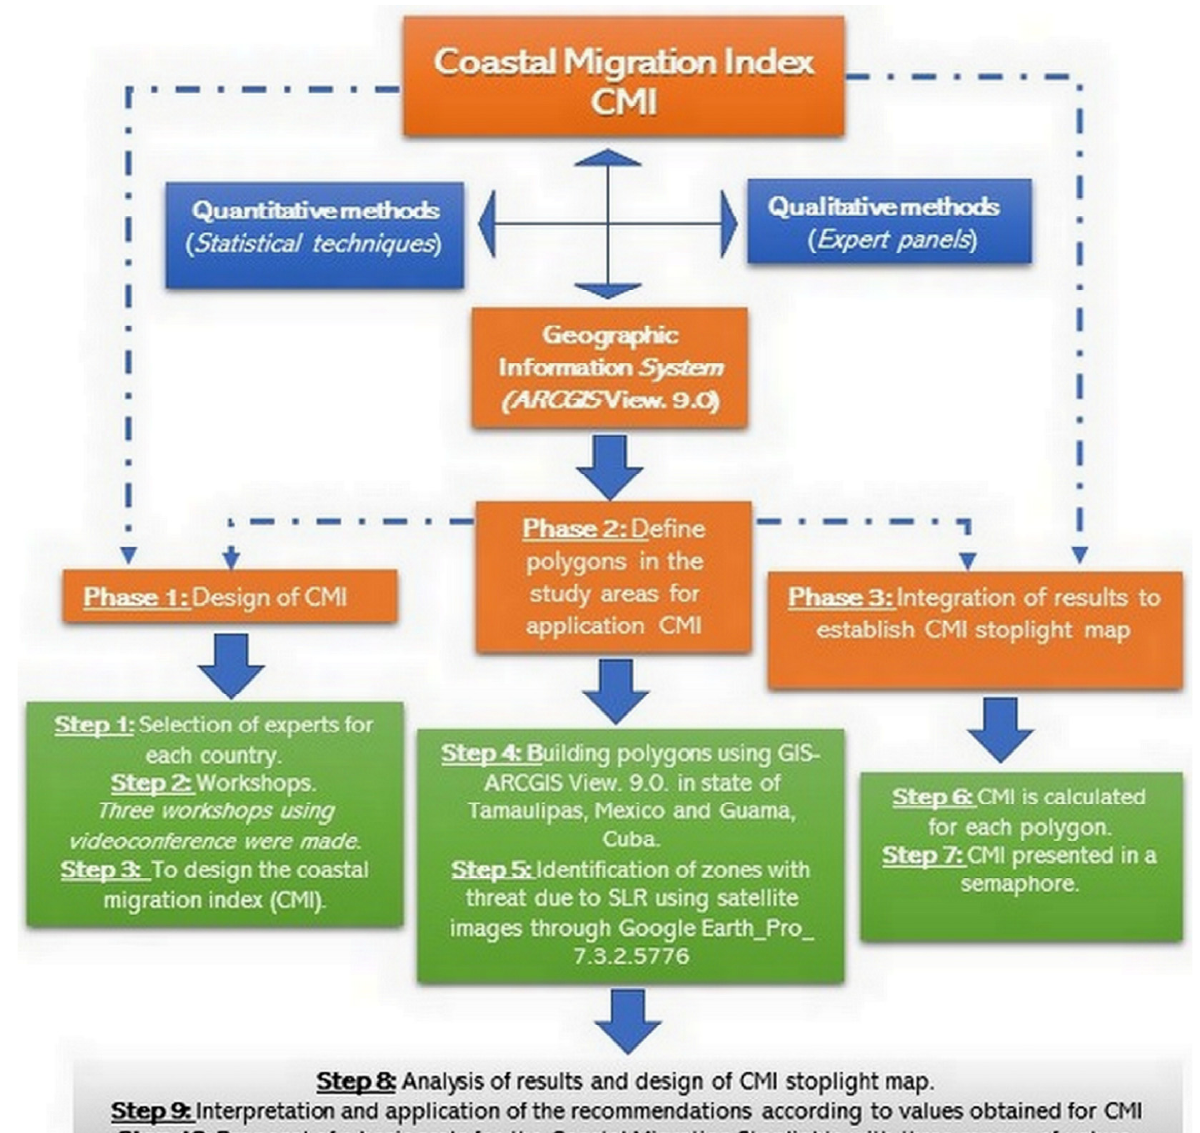
Figure 1. Methodological scheme followed in this paper.